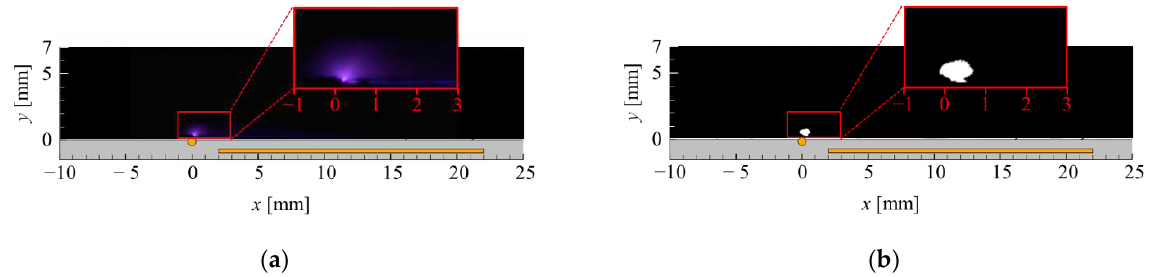
Figure 12. Forming mechanism of the flow and density field of the plate-PA.